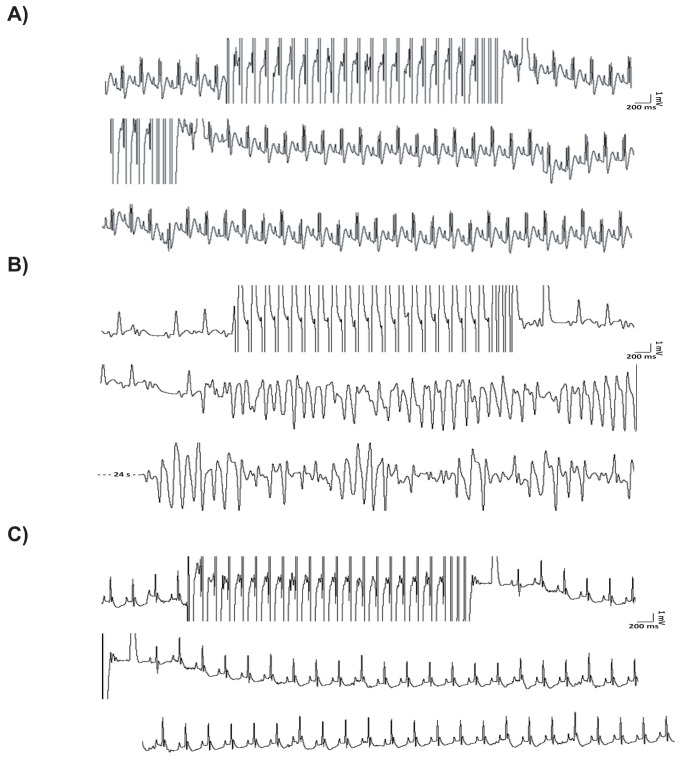
Susceptibility to the onset of ventricular tachyarrhythmias assessed during programmed electrical stimulation.
A: Programmed electrical stimulation (PES) was performed with a dedicated bipolar catheter, which was advanced anterogradely into the right ventricle. A train of N=20 impulses at 100ms of basal cycle length followed by three extrastimuli at 50ms was used in each case; no arrhythmias were inducible in rats from neither SHAM nor SHAM+ VAL groups. B: R-on-T phenomena before and after stimulation in hypertrophied rat hearts with the induction of a sustained ventricular tachycardia at the end of stimulation. C: In contrast, after valsartan administration only ventricular extra beats were inducible in hypertrophied rats in which stable sinus rhythm was restored at the end of stimulation. Central strips from each panel start from previously recorded 1000ms of respective upper strips, as for bottom strips from panels A and C, whereas bottom strip from panel B is postponed of 24 seconds due to induction of sustained ventricular tachycardia.